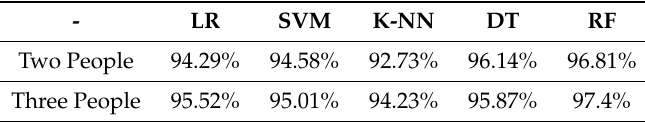
Table 18. Overall model accuracy for different algorithms.